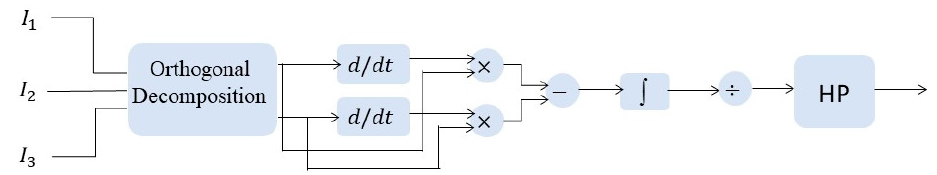
Figure 2. Interference demodulation method based on 3 × 3 coupler.